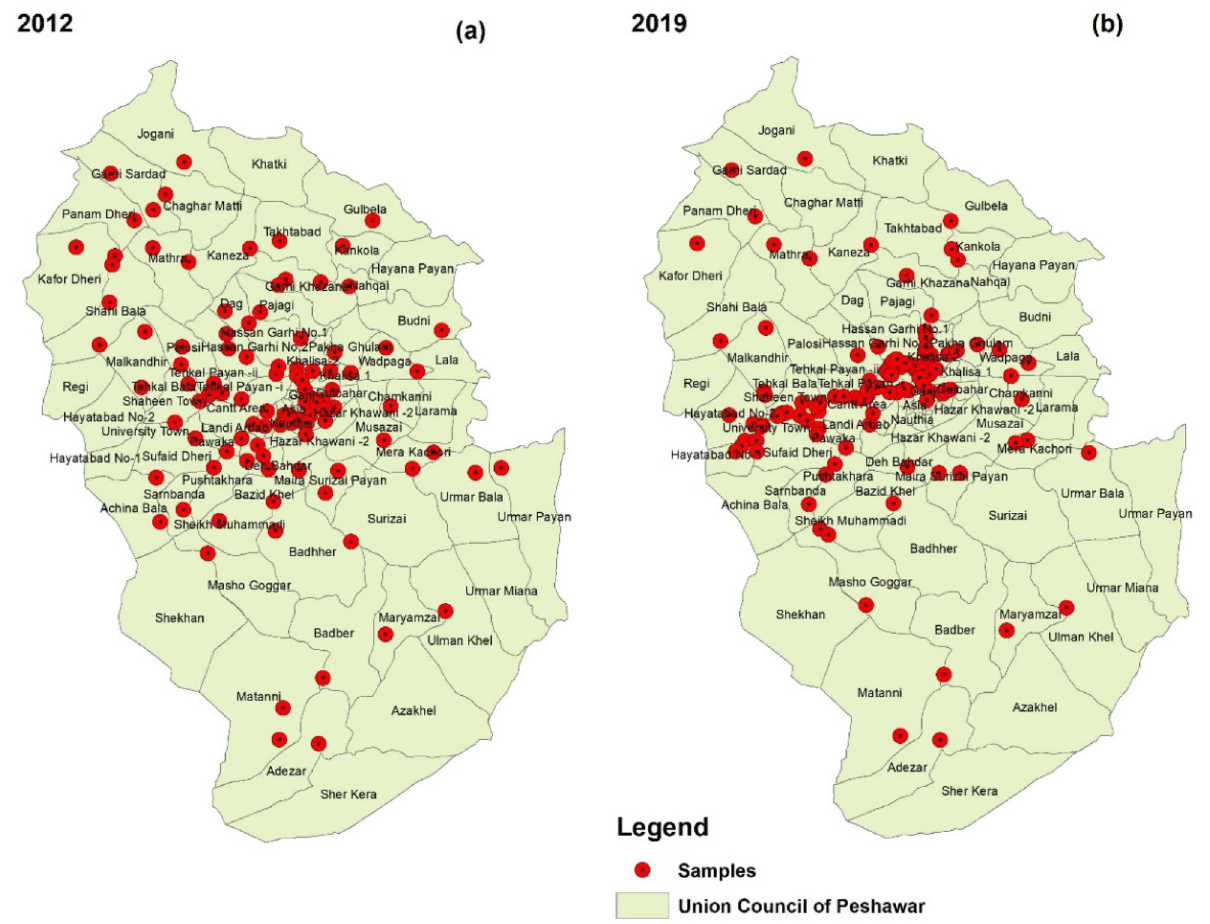
Figure 2. Showing the sample location of tube wells ( a ) the 2012 sample locations in different Union Councils and ( b ) the 2019 sample location point.